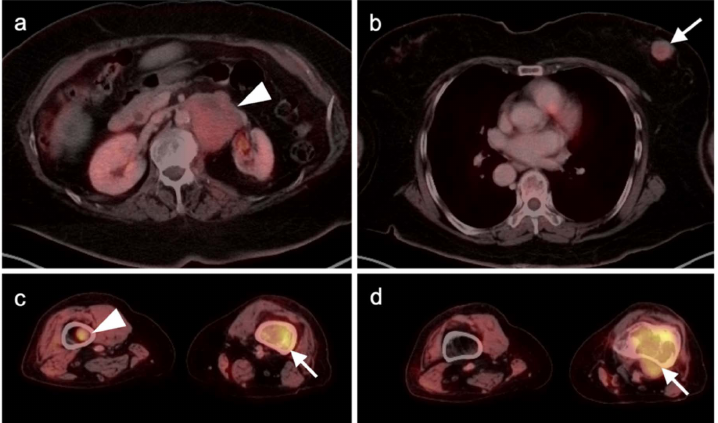
Figure 16. Leiomyosarcoma of the retroperitoneum with late metastatic disease. ( a ) Axial FDG PET- CT image of the abdomen shows a mildly hypermetabolic retroperitoneal mass (white arrowhead) which was known to be present for 4 years before metastasizing. ( b ) Axial FDG PET-CT of the chest shows a hypermetabolic left breast mass, biopsy-proven metastatic leiomyosarcoma (white arrow). ( c , d ) Axial FDG PET-CT images of the thighs show metastatic leiomyosarcoma in both femurs (white arrows and arrowhead), with an associated soft tissue mass associated with the left femoral lesion (( d ), white